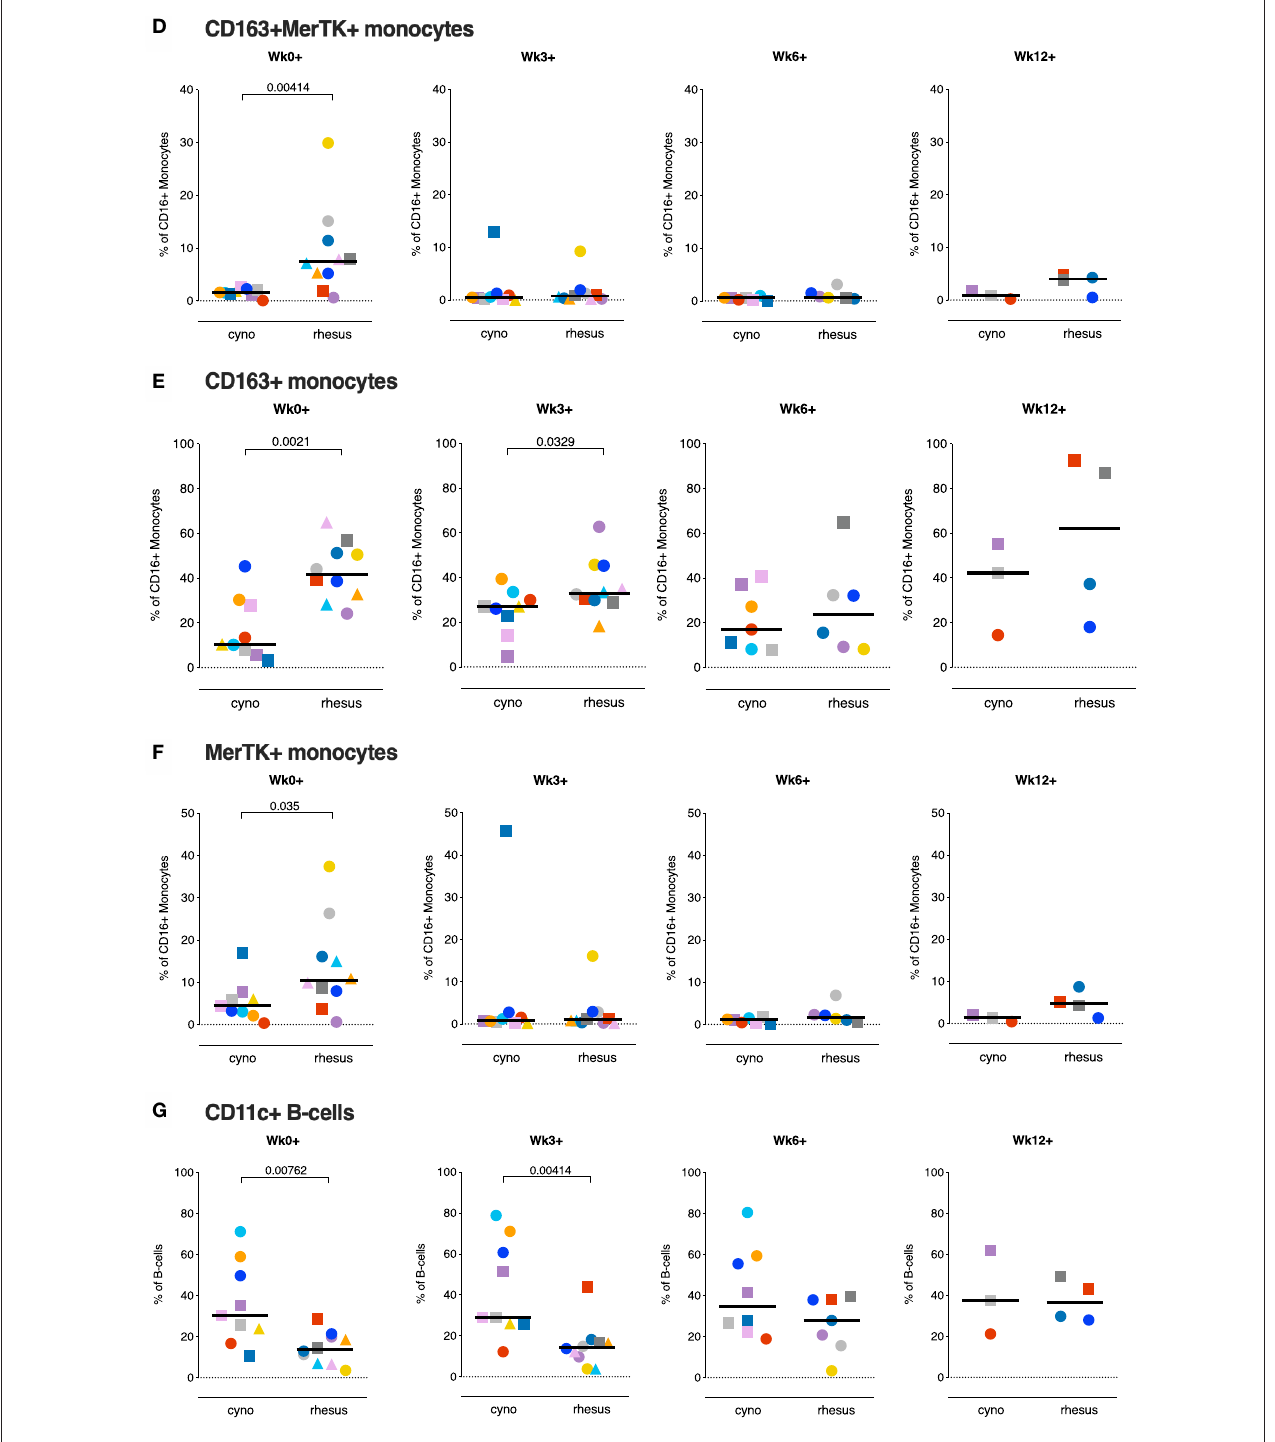
FIGURE 6 | Monocytes of cynomolgus and rhesus macaques show different functional phenotypes before and after Mtb infection. (A–C) Percentage TNFa, IL12p40/p70, and IL8 positive monocytes of total CD14 + monocytes after overnight stimulation of peripheral whole blood with culture medium (–) or Mtb Whole Cell Lysate ( + ). (D–F) ex vivo expression of CD163 and MerTK on CD16 + monocytes from peripheral whole blood. (G) Percentage of CD11c + B-cells in peripheral whole blood. Data are aligned to the moment of each individual’s time point of infection take. Number of animals per time point varies due to sample availability. For (D–F) ; samples that contained < 100 events in the CD16 + monocyte gate were excluded from analysis. Horizontal lines indicate group medians. Significance of group differences was determined by two-sided Mann-Whitney test. Color coding per individual, as defined in Table 1 , is consistently applied throughout.